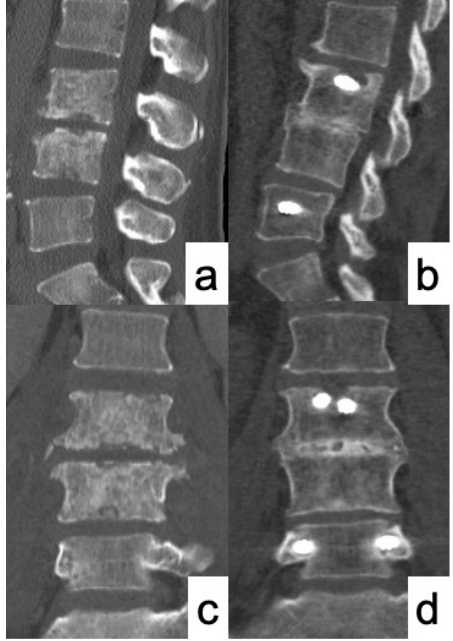
Figure 3. Comparison of CT images before surgery and 12 months after surgery. ( a , c ) CT images before surgery showed destructive change of L3 and L4 vertebral bodies; ( b , d ) CT image at 12 months after surgery showed good bony union with callus bridging between L3 and L4.